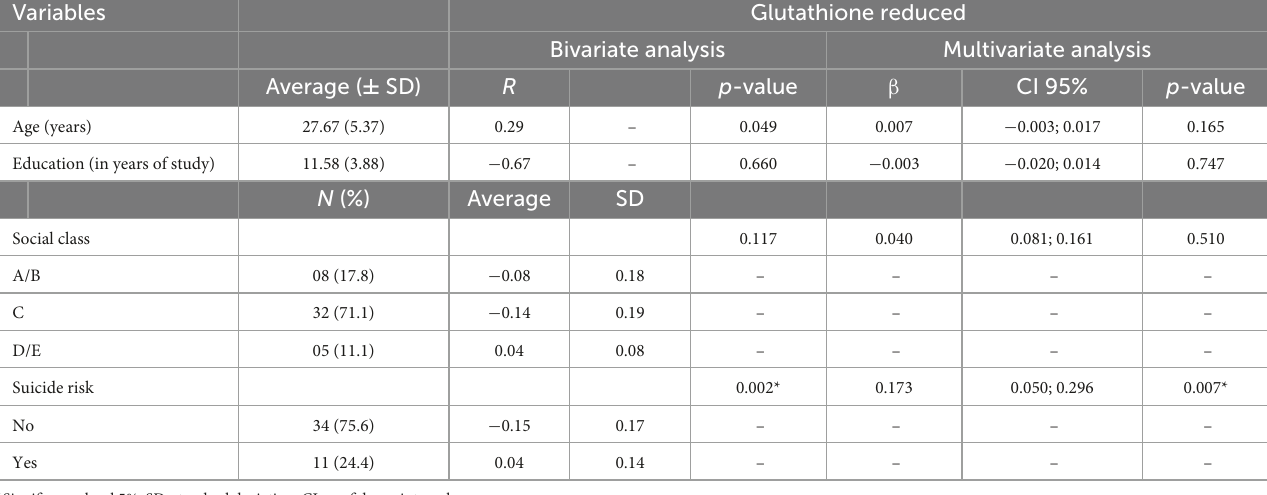
TABLE 2 Analysis of the serum level of glutathione according to age, education in years, social class (A/B, C, and D/E), and risk of suicide diagnosed by MINI-Plus (Yes/No) of women at 18 months postpartum. Variables